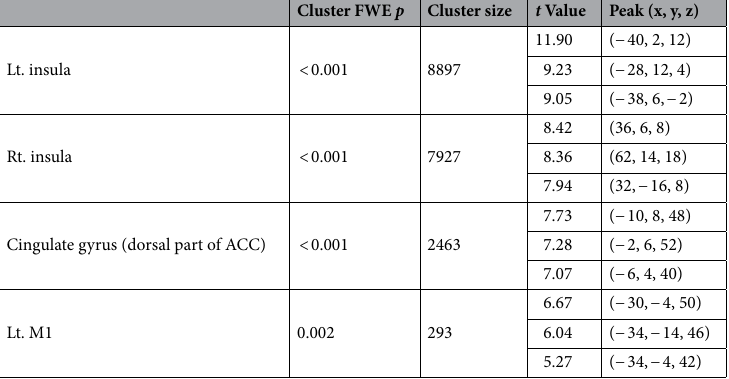
Table 4. The functional connectivity area correlated with BMI decrease seeding the left putamen cluster at Time2. We present only the significant brain regions within the cerebral cortex (excluding the cerebellum and brainstem clusters for presentation purposes). The statistical threshold for significant differences was set at FWE corrected p < 0.05, at the cluster level with uncorrected p < 0.001 at the voxel level. ACC, anterior cingulate cortex; BMI, body mass index; FWE, family-wise error; Lt, left; Rt, right; M1, primary motor